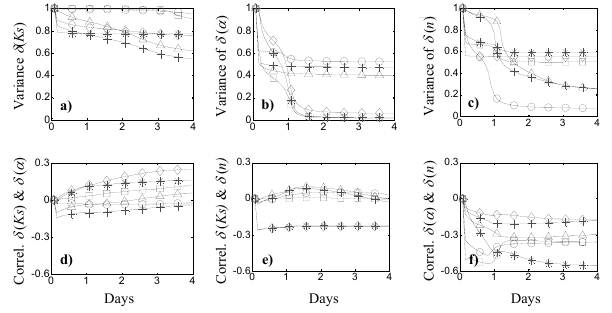
Figure 6. Evolving variances of the correction terms (a) δ ( K s ), (b) δ ( α) and (c) δ ( n) associated with the VGM parameters and correlations (d–e) between these terms during the first 4 days using the GA3 data series, with assimilation frequency AF = 1/2h − 1 and observation depth OD =